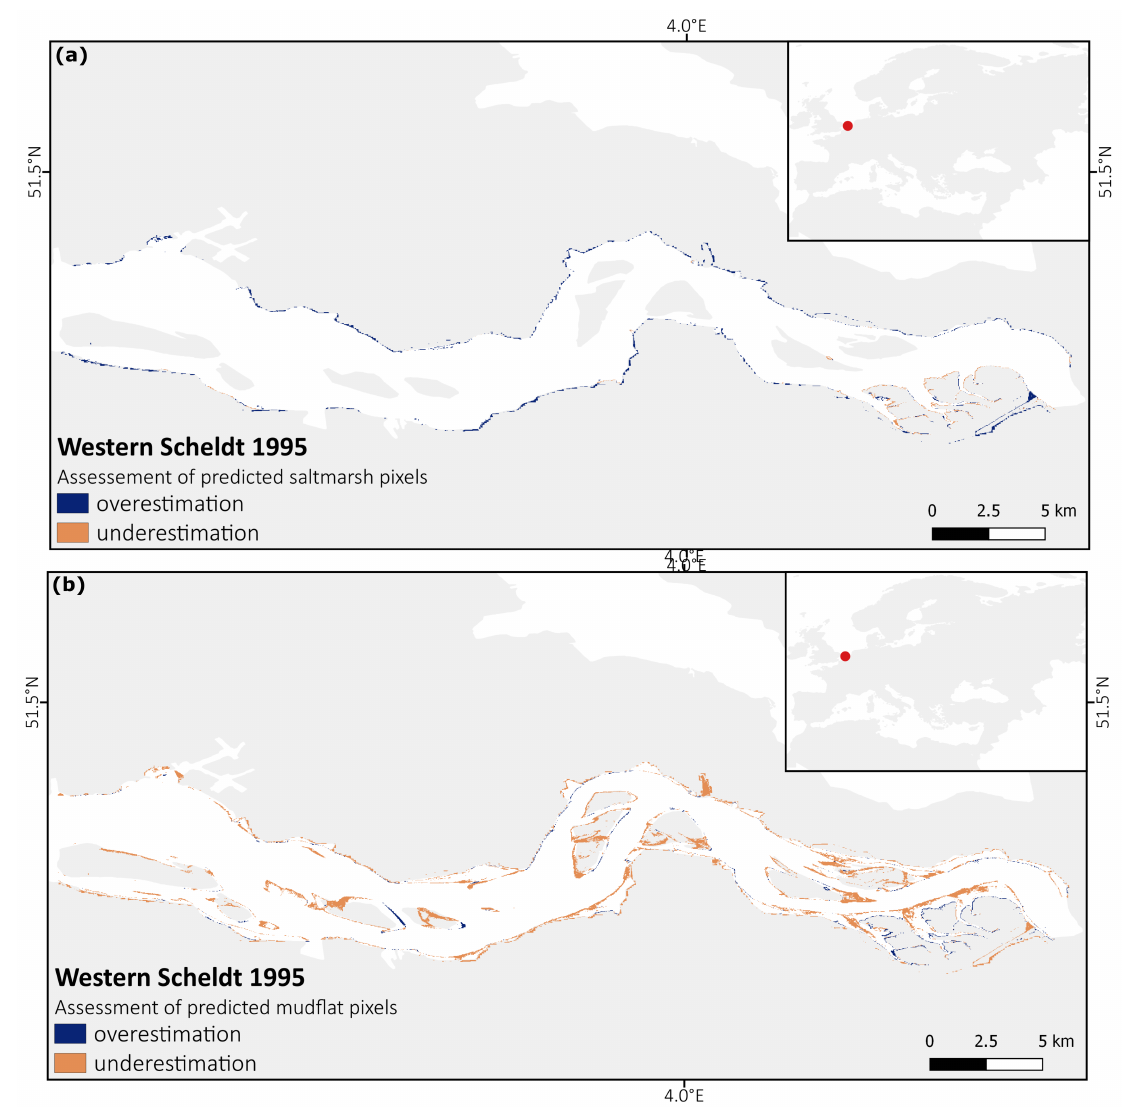
Figure A1. Change detection between the validation image and the classified image. It demonstrates the spatial distribution of mismatched ( a ) saltmarsh pixels and ( b ) mudflat